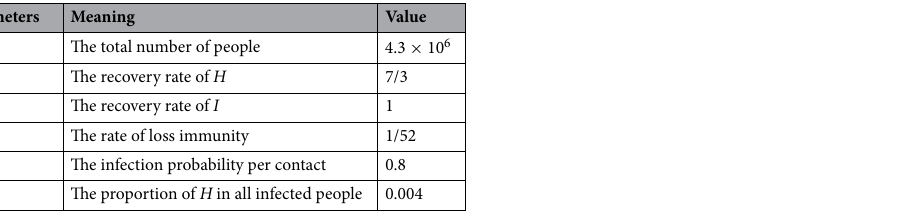
Table 2. Notation for model formulation and parameters